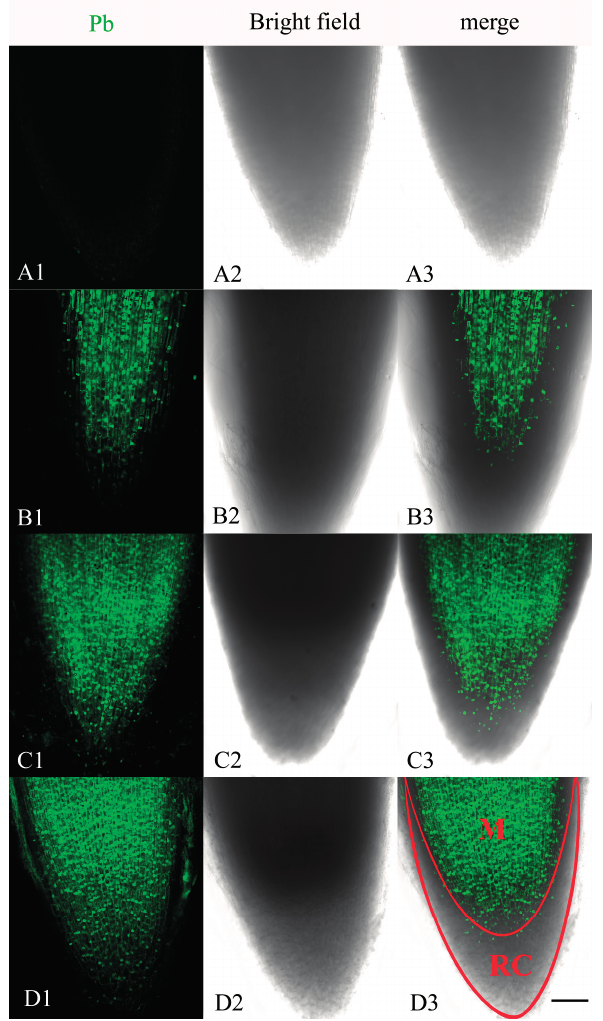
Figure 1. Confocal laser scanning microscope micrographs from root tip meristematic cells of A. cepa exposed to Pb(NO ) for 4, 24 and 48 h, using Leadmium™ Green 3 2 AM dye (Invitrogen). ( A1 , B1 , C1 , D1 ) Pb detection; ( A2 , B2 , C2 , D2 ) Bright field image; ( A3 , B3 , C3 , D3 ) Merged image of “Pb detection” and “bright field image”. All images are taken at ×10 magnification, and green fluorescence represents the binding of the dye to Pb. One of six typical examples is selected for each treatment. Scale bars = 100 μ m. M = meristematic zone. RC = root